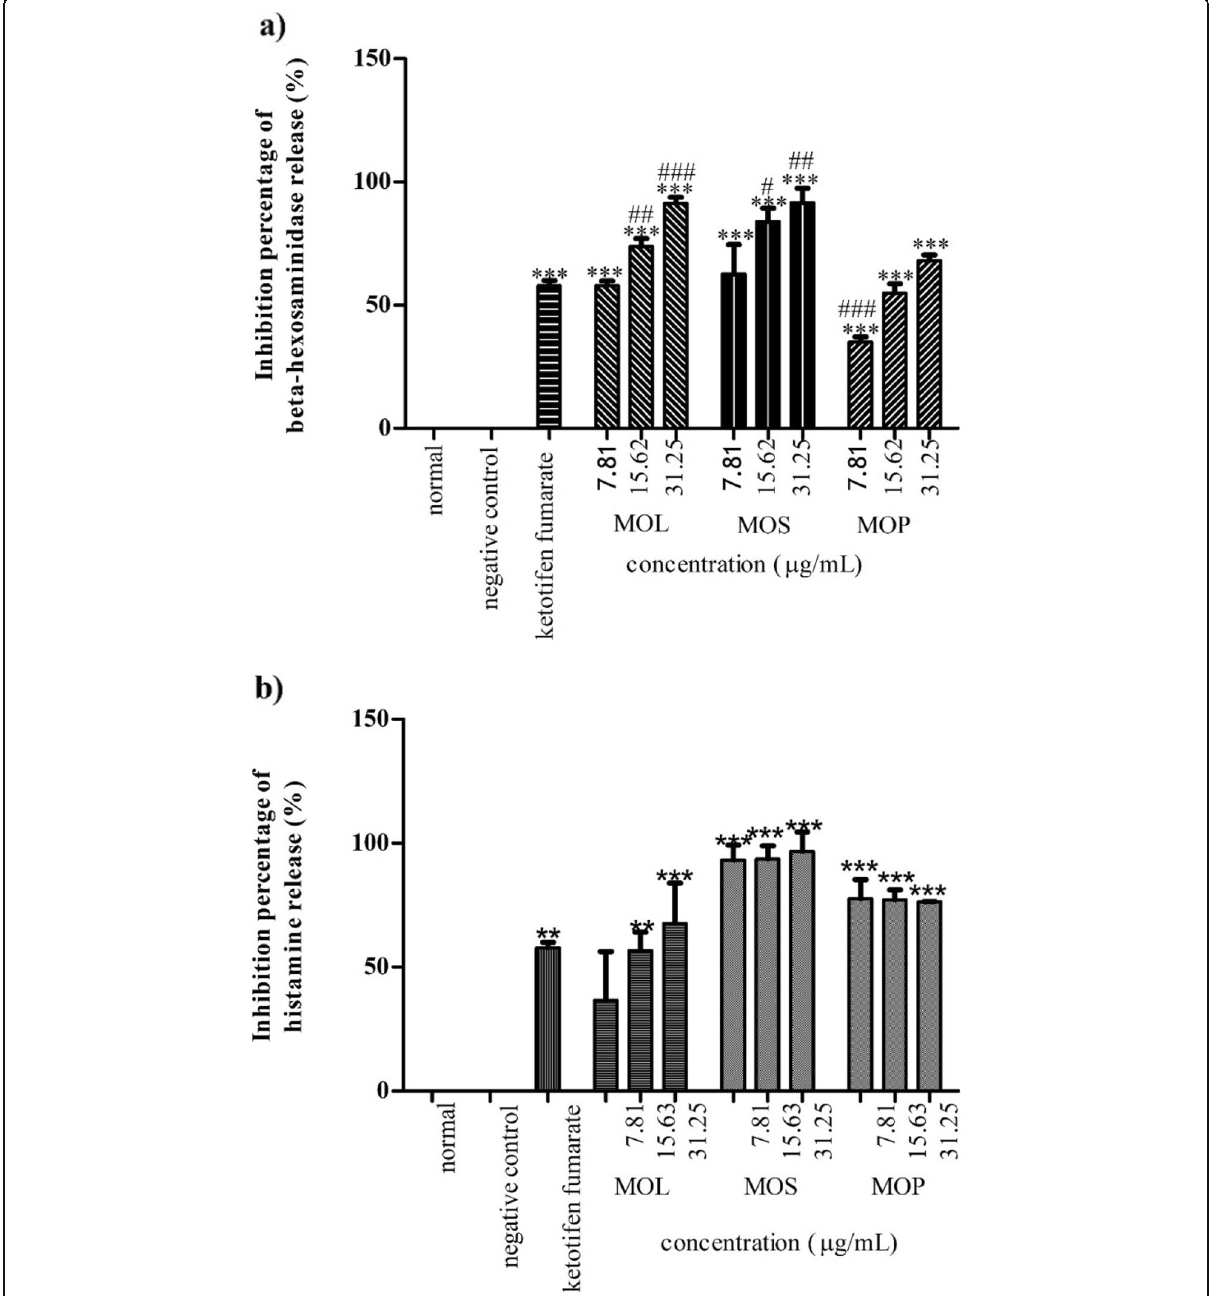
Fig. 3 Percentage inhibition of M. oleifera crude extracts on a ) beta-hexosaminidase and b ) histamine releases. Data are presented as mean ± SEM ( n = 3) with significant value of ** p < 0.01, *** p < 0.001 as compared to positive control and # p < 0.05, ## p < 0.01, ### p < 0.001 as compared to ketotifen fumarate (15.62 μ g/mL). MOL: M. oleifera leaves, MOS: M. oleifera seeds, MOP: M. oleifera